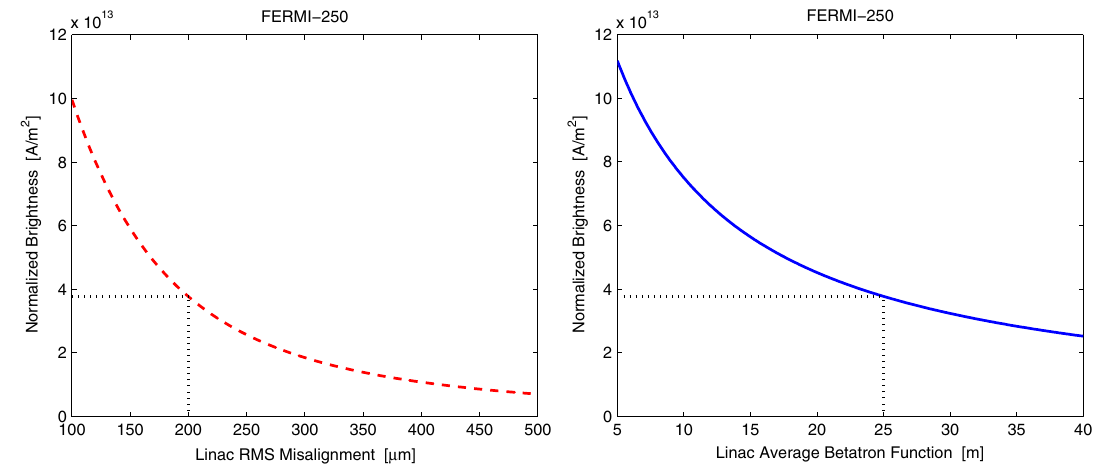
FIG. 4. Final brightness for the FERMI-250 scenario as a function of the linac rms misalignment (cid:1) (left) and linac average betatron (cid:2) (cid:1) function (right). Dotted lines in both plots identify the actual working point (see Table I).